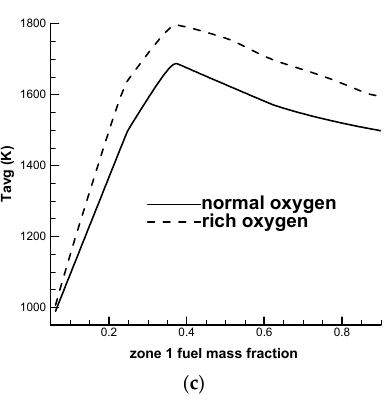
Figure 4. A comparison of the maximum and average temperatures for a SRU thermal reactor with different zone 1 fuel mass fractions: ( a ) Maximum temperature; ( b ) The average temperature in zone 1; ( c ) The average temperature in the thermal reactor.